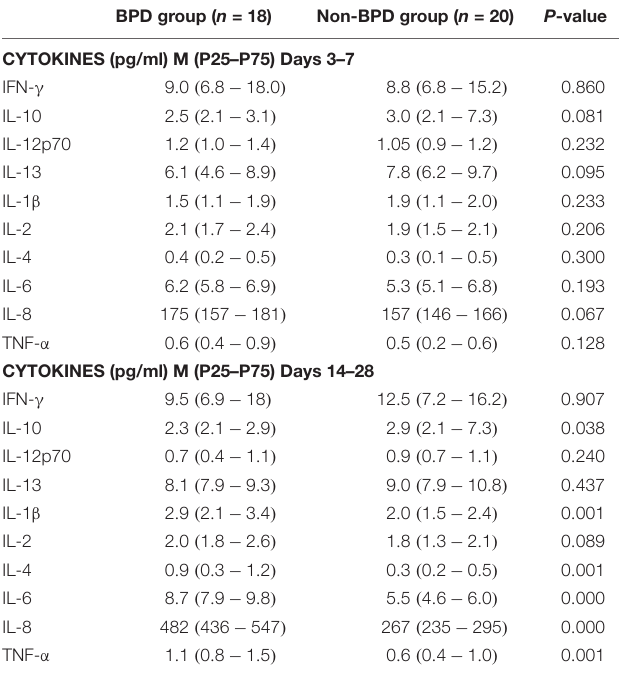
TABLE 3 | The cytokines of the patients.